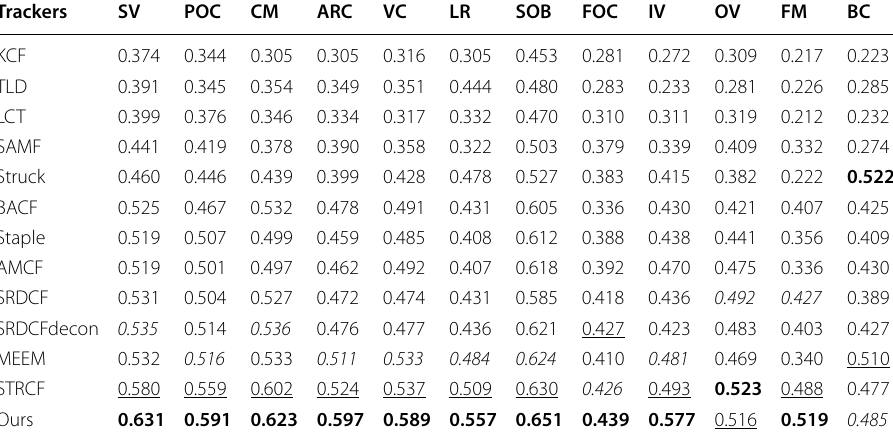
The top three ranking trackers in each attribute are marked in bold, underlined, and italic fonts, respectively